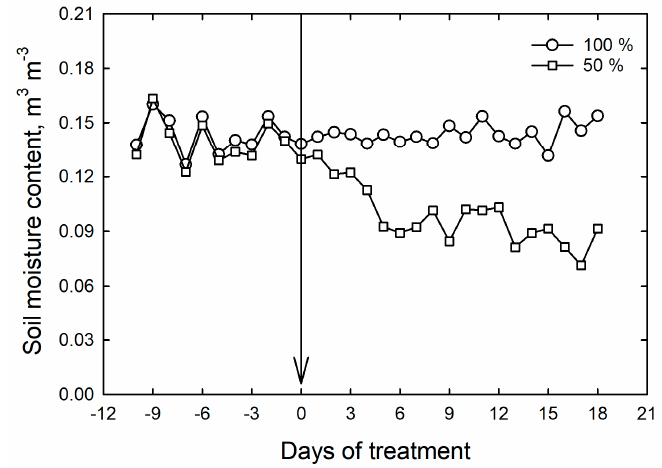
Figure 2. Real-time management of soil moisture status of the trial under the control and drought treatments. The arrow indicates the day when the treatments were imposed. Bars indicate standard errors of the mean of ± three replications.